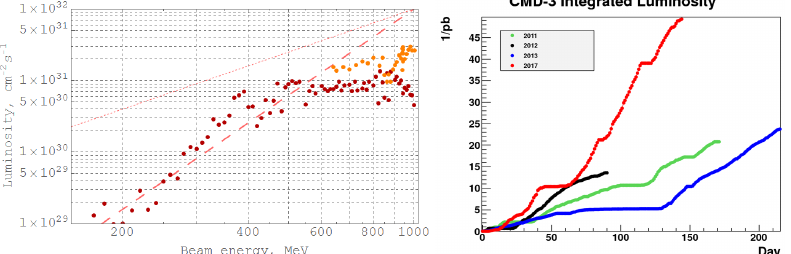
Fig. 4. Left: achieved averaged luminosity at CMD-3; orange dots show luminosity after complex upgrade. Right: Luminosity integral collected by CMD-3.